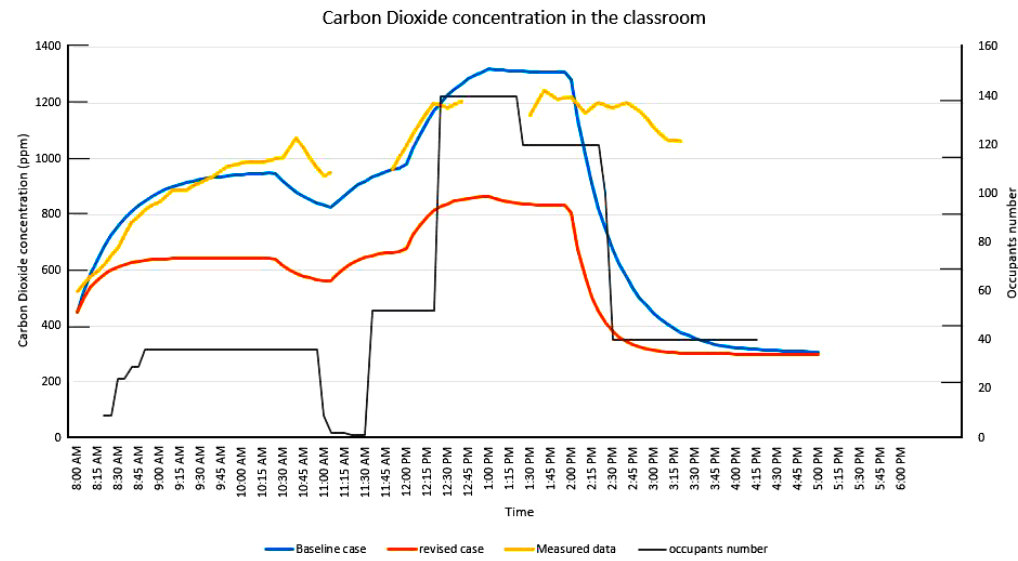
Figure 8. Carbon dioxide concentration compared between measured and simulated model. Note that the measured data is segments due to the disruption of the equipment; however, the concentration increase can still be